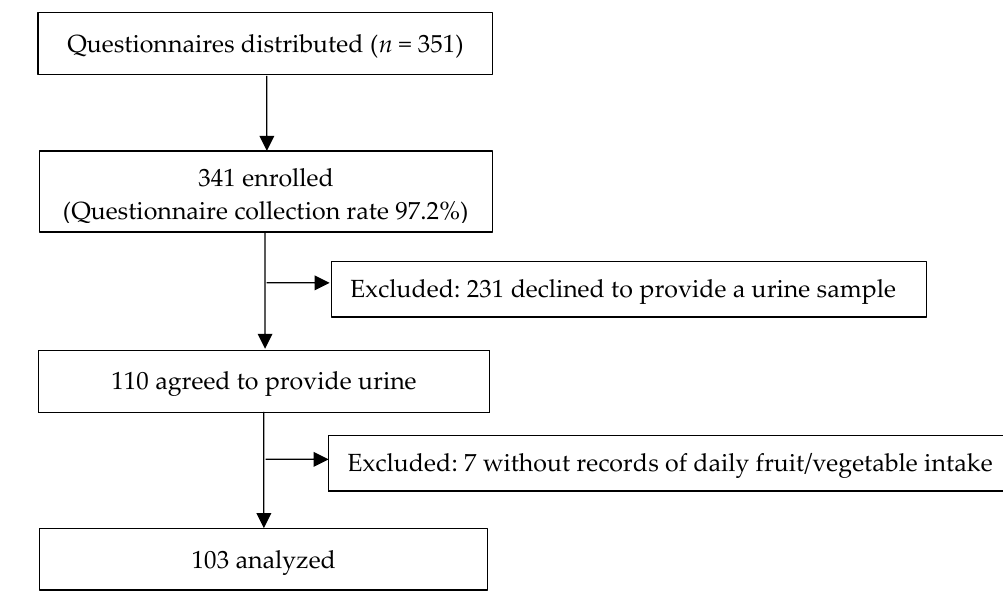
Figure 1. Flow chart of participant recruitment.